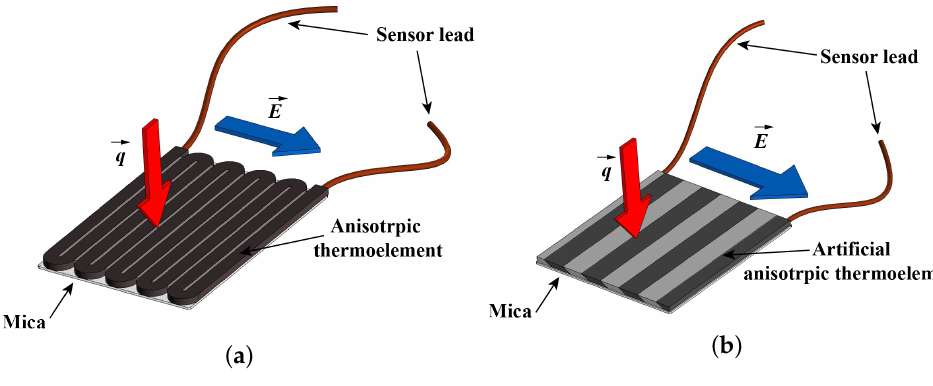
Figure 1. Scheme of GHFS ( a ) and HGHFS ( b